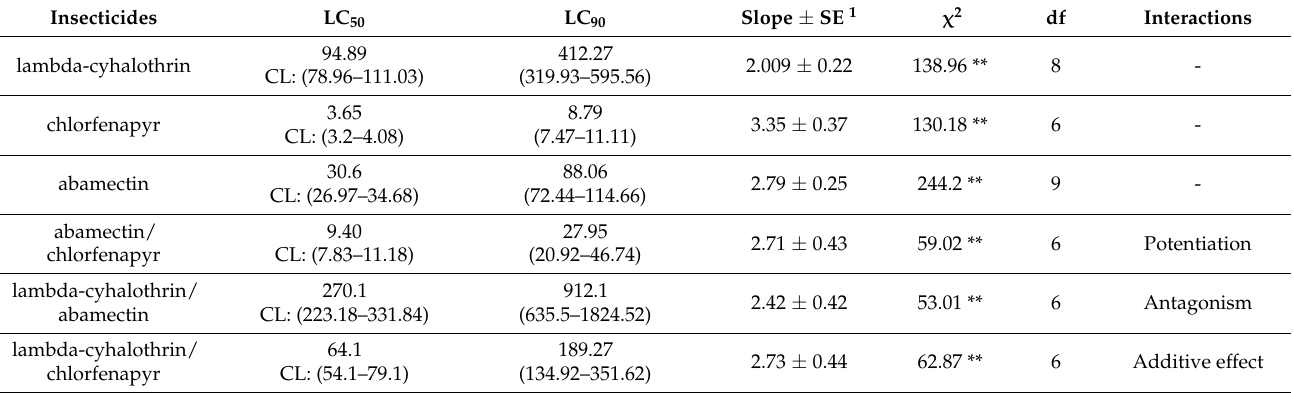
Table 1. The LC 50 , LC 90 (in ppm), Slope, χ 2 and df of the tested insecticides against M. domestica larvae, 24 h post